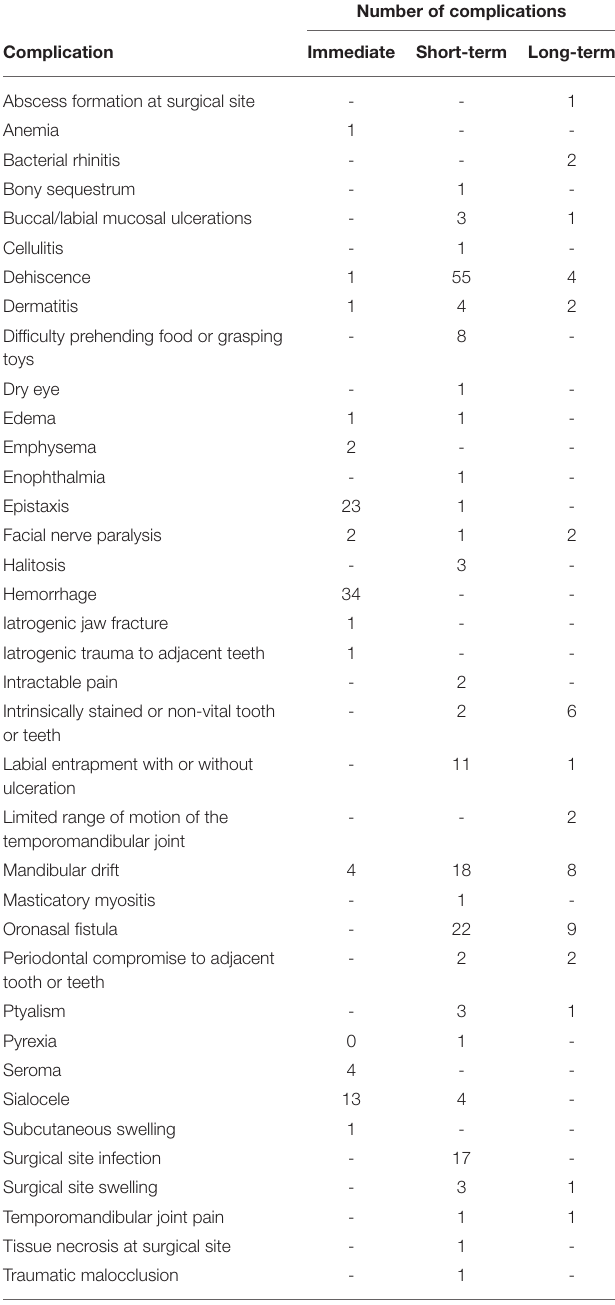
TABLE 2 | Description of all complications ( n = 301) by time of identification. Number of